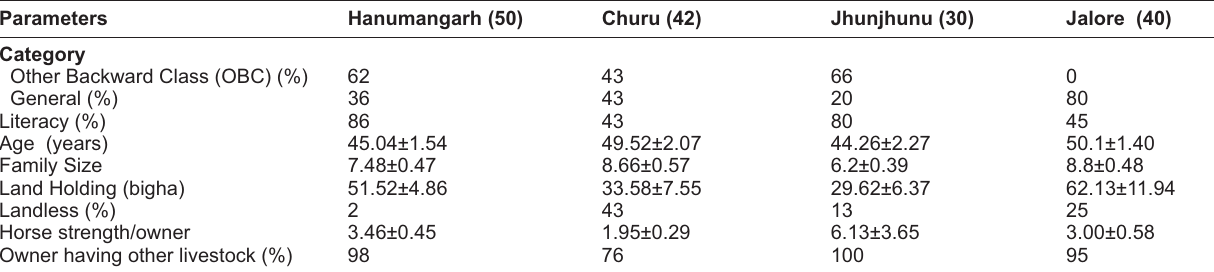
Table-1. Socio-economic status and family inventories of respondents Parameters